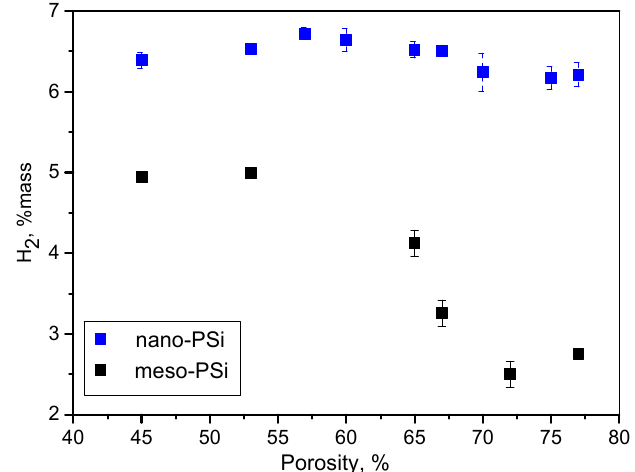
Figure 9. Porosity dependent hydrogen generation amount due to oxidation reaction of meso- and nano-PSi powders in H 2 O:Ethanol:NaOH solutions at room temperature. Alkali concentration was 0.5 M/L.